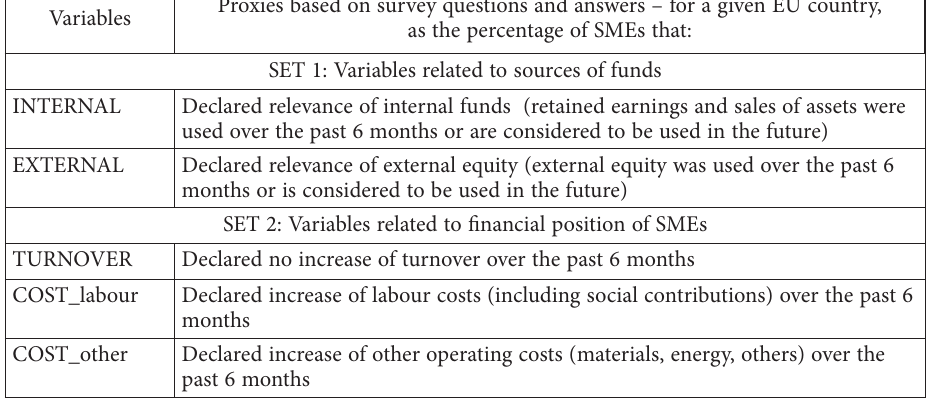
Table 2. Variables and their survey-based proxies Variables